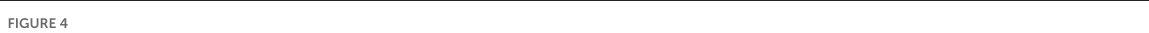
FIGURE4 and DG. The quantification graphs are demonstrated on the right panels. (B) The expression of GFAP in CA1, CA3, and DG of the hippocampus was significantly increased in 3xTg-untreated and -vehicle groups. M01 treatment significantly decreased the GFAP expression. The quantification graphs are demonstrated on the right side. Scale bar: 100 µ m. The results are plotted as the mean ± SEM. * p < 0.05, ** p < 0.01, *** p < 0.001 and n = 3–4 mice/group and 3 sections/mice for IF.